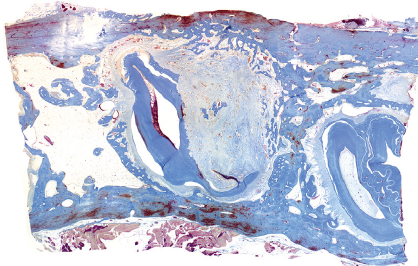
Figure 13: Histotopogram of the rabbit’s mandible slice 4weeks after the formation of a bone defect and introduction of a sus- pension of calcium hydroxide with nanodispersed cerium